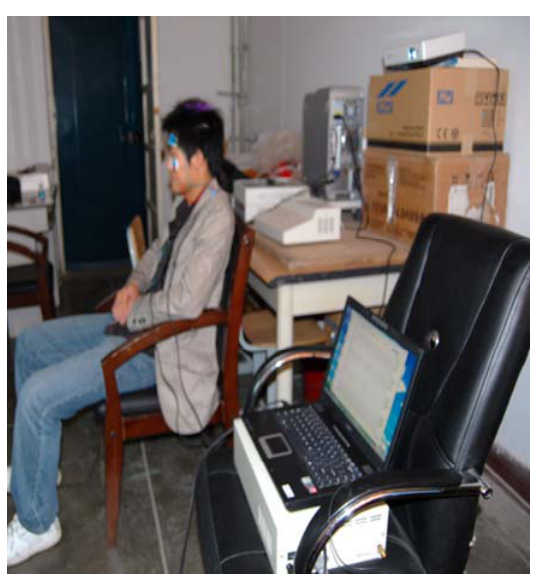
Fig.2. The scene of laboratory simulation